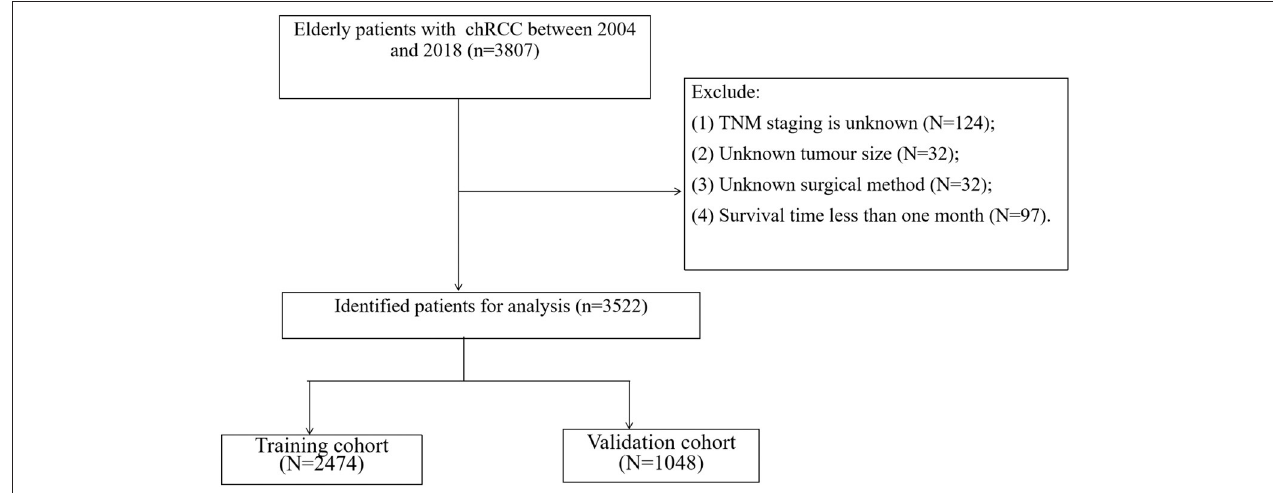
FIGURE 1 | Flow chart of patient